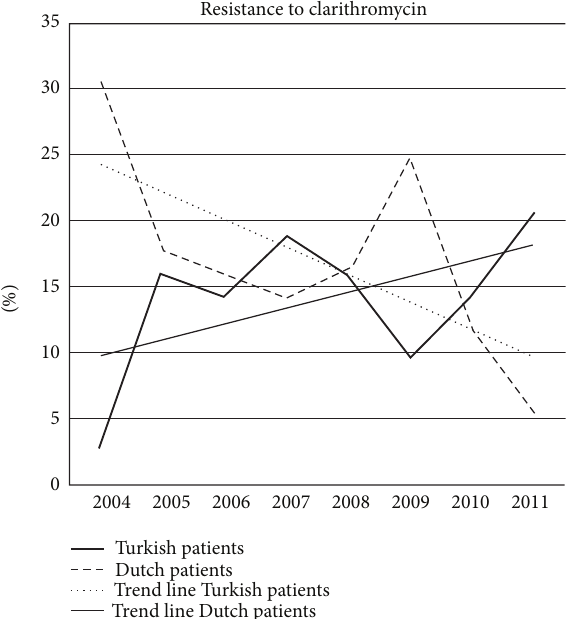
Figure 3: Resistance to clarithromycin in Dutch patients and Turkish patients in the consecutive eight